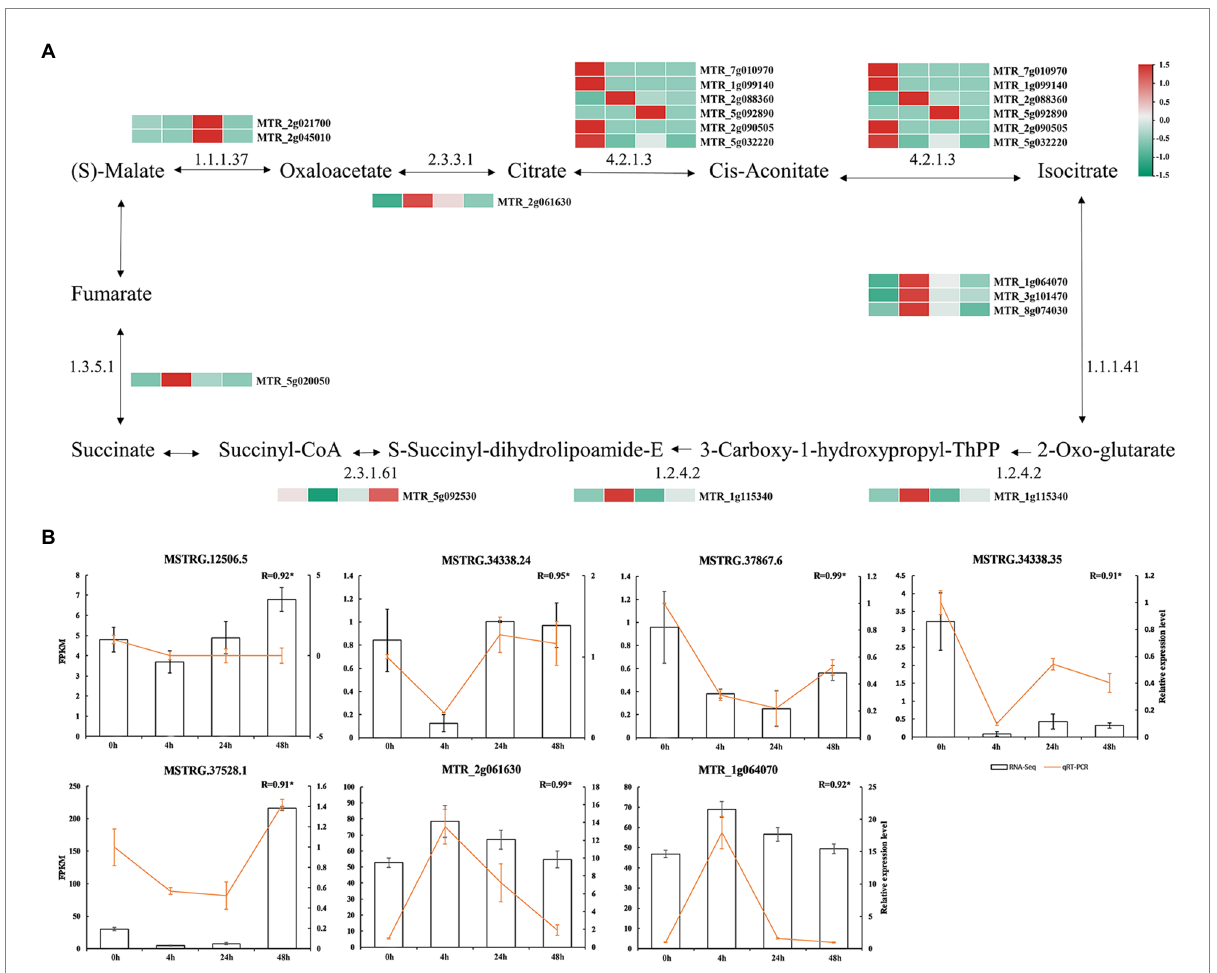
FIGURE 5 Malate and citric acid metabolic pathways. (A) mRNA involved in the regulation of malate and citric acid metabolism. The colored blocks represent the aluminum stress treatment time, 0 h, 4 h, 24 h and 48 h from left to right. (B) Validation of lncRNAs. Bars represent RNA-Seq and yellow lines represent qRT-PCR.